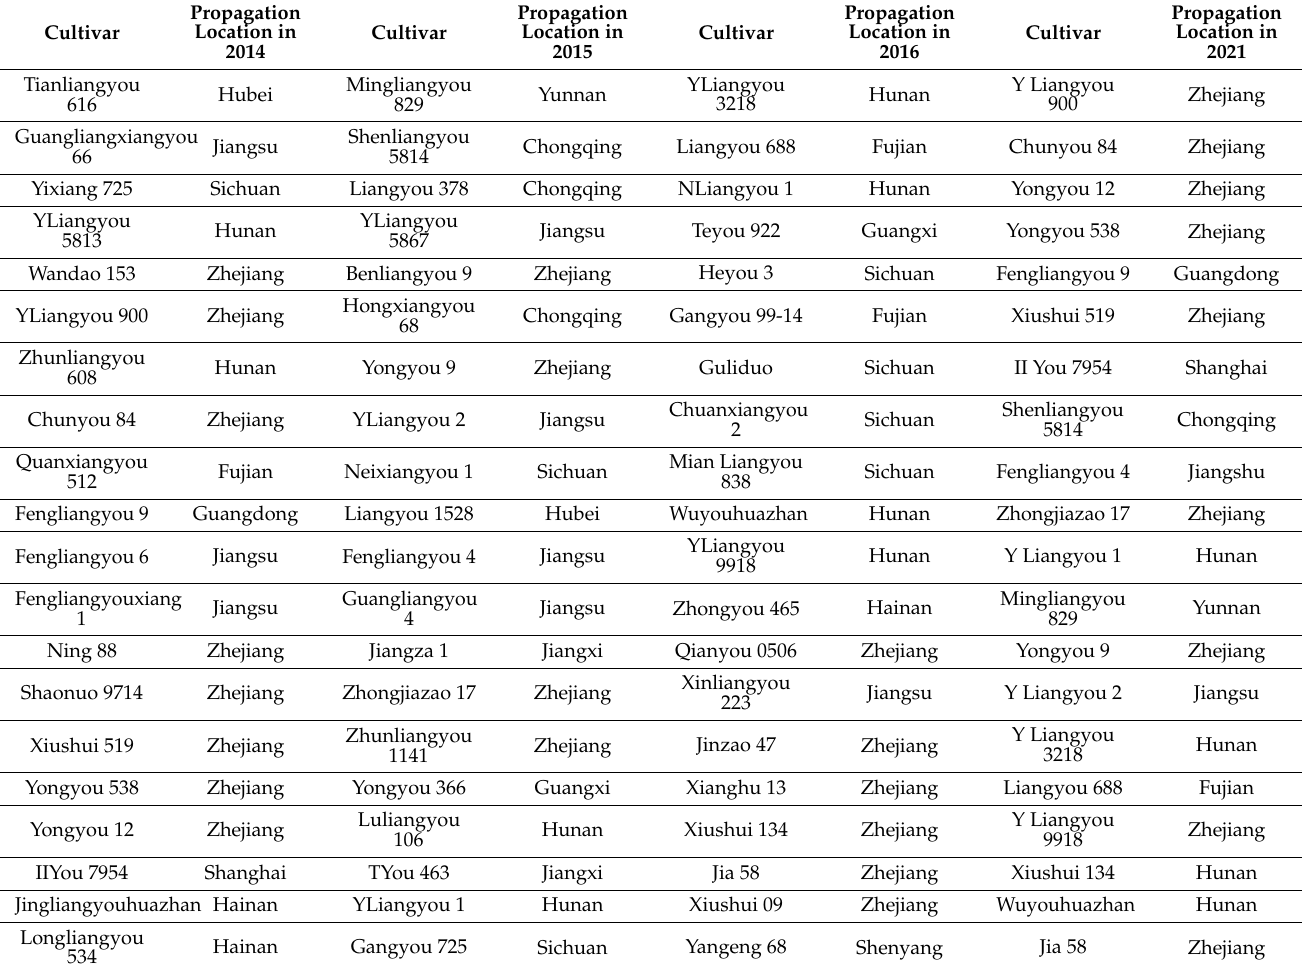
Table 1. Details of different rice cultivars collected from major propagation